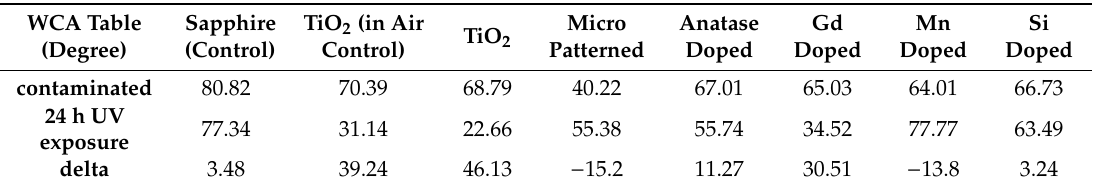
Table 1. Average water contact angle (WCA) of the tested coatings before and after 365 nm UV exposure for 24 h submerged in flowing tap water.